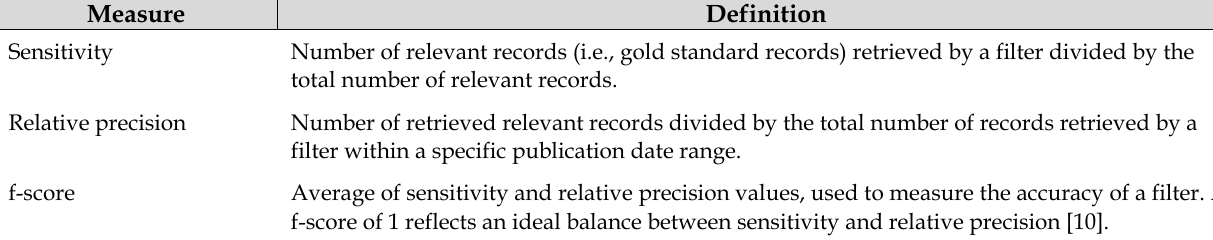
Table 1 Definitions of sensitivity, relative precision, and f-score